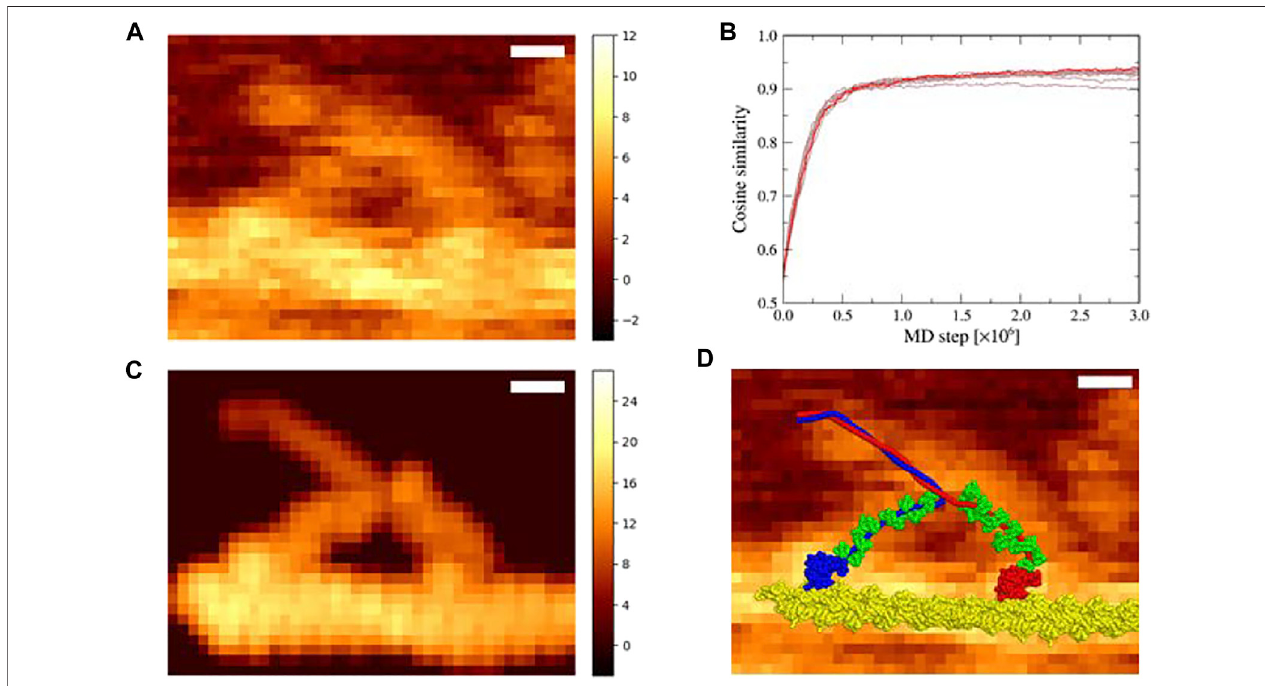
FIGURE 3 | Flexible fi tting simulation of the actin-myosin complex in the down-down state. (A) The corrected experimental AFM image used as a reference in the simulation; scale bar, 10 nm; color bar in nm (same as Figure 2A ). (B) Time series of the cosine similarity for ten independent simulation runs are shown in brown. The trajectory involving the largest value is colored in red. (C) The pseudo-AFM image with the highest cosine similarity created using afmize (Niina et al., 2020a; Niina et al., 2020b); scale bar, 10 nm; color bar in nm. (D) Structure model of the actin-myosin complex with the highest cosine similarity on top of the reference AFM image; scale bar, 10